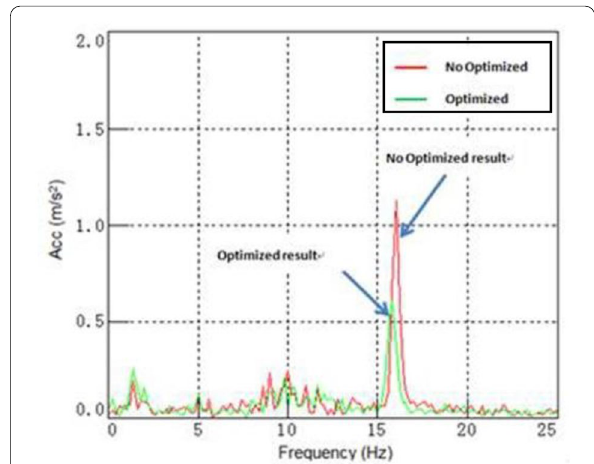
Figure 19 Acceleration vs. frequency curves